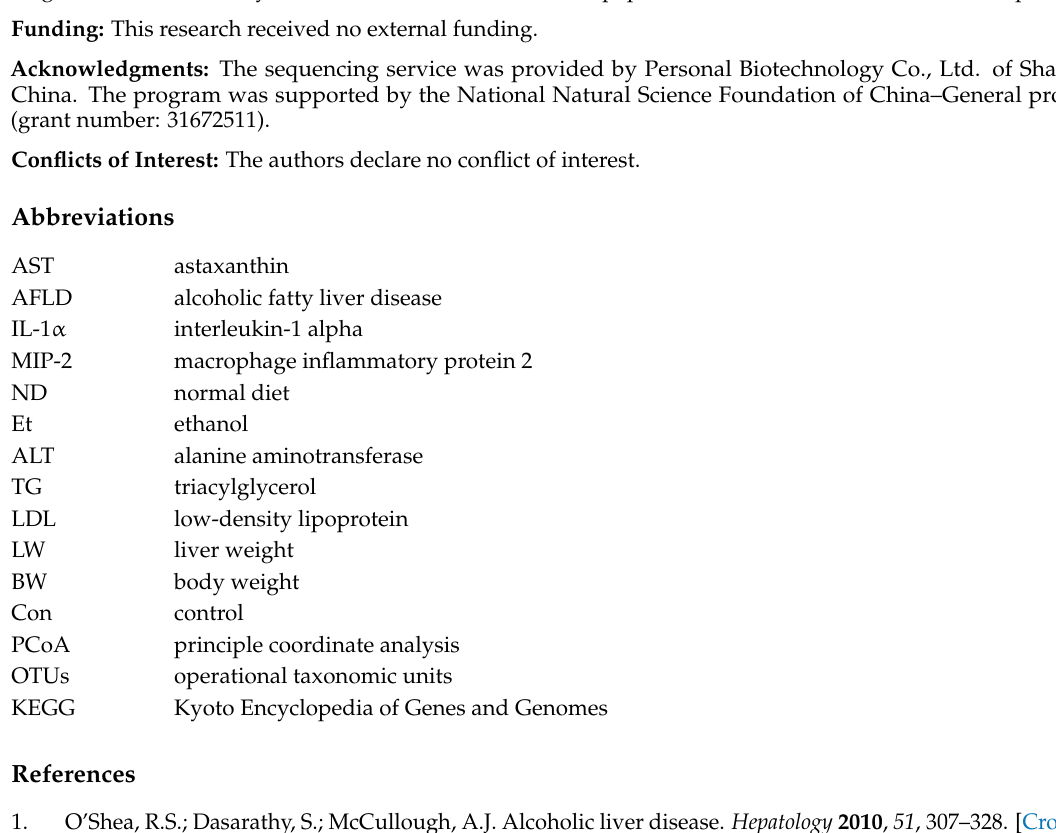
s1, Table S1: Compositions of the diets (DOC); Table S2: Primer sequences used for q-PCR reactions (DOC); Table S3: The OTUs obtained from high-throughput 16S rRNA gene sequencing (XLS); Figure S1: Rationality of sequencing data was evaluated by rarefaction and rank abundance curve (DOC 359); Figure S2: Cluster analysis using the UPGMA method based on unweighted Unifrac and weighted Unifrac analysis (DOC); Figure S3: The overall classification levels based on GraphlAn and LEfSe analyses were used to visualize the taxonomy compositions and bacterial abundance; Figure S4: Heatmap of the abundance of bacteria at the genus level at different groups (DOC); Figure S5: Astaxanthin protect ethanol-induced Akkermansia muciniphila depletion (DOC); Figure S6: Predicted functions for the altered metagenome of gut microbiota